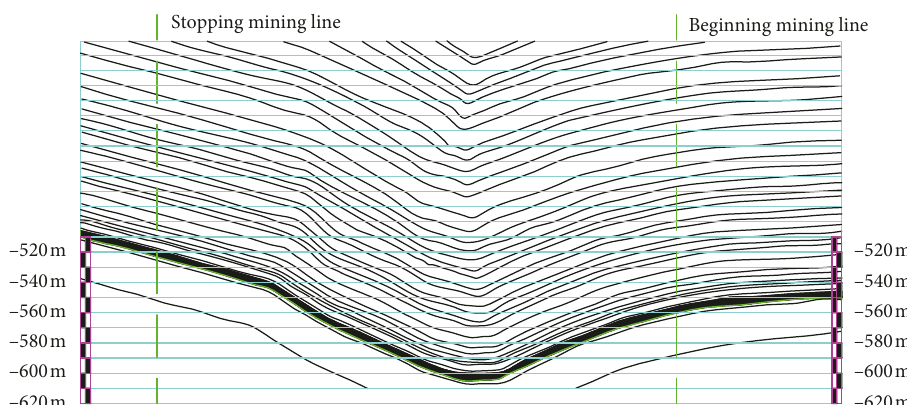
Figure 1: Distribution of coal and rock strata in physical similarity simulation experiment.